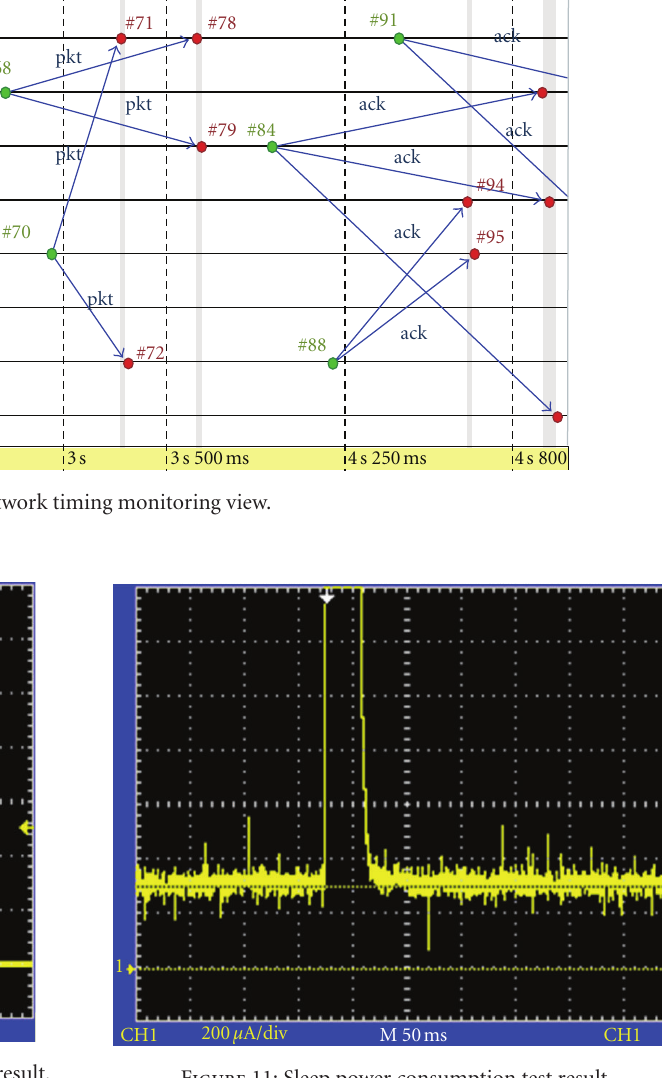
Figure 10: Receiver WOR period—power consumption test result. Figure 11: Sleep power consumption test